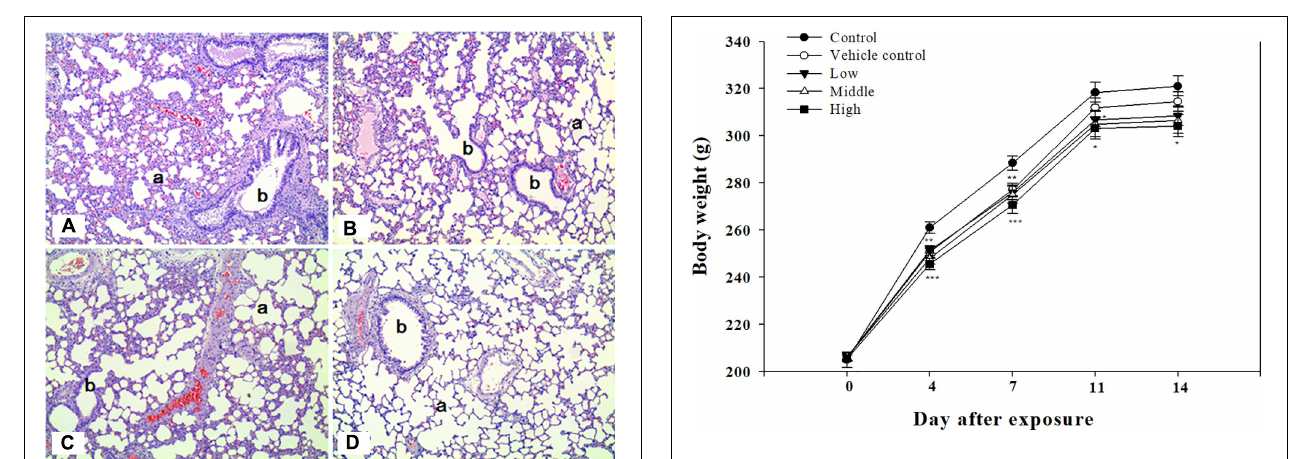
FIGURE 6 | Histopathological staining of the lungs in male rats exposed to SM for 2 weeks by inhalation. No specific abnormal findings were noted in the lungs. a, alveoli; b, bronchiole. (A) Control group; (B) low-exposure group; (C) medium-exposure group; (D) high-exposure group; H&E staining. Magnification = × 100 for all images.